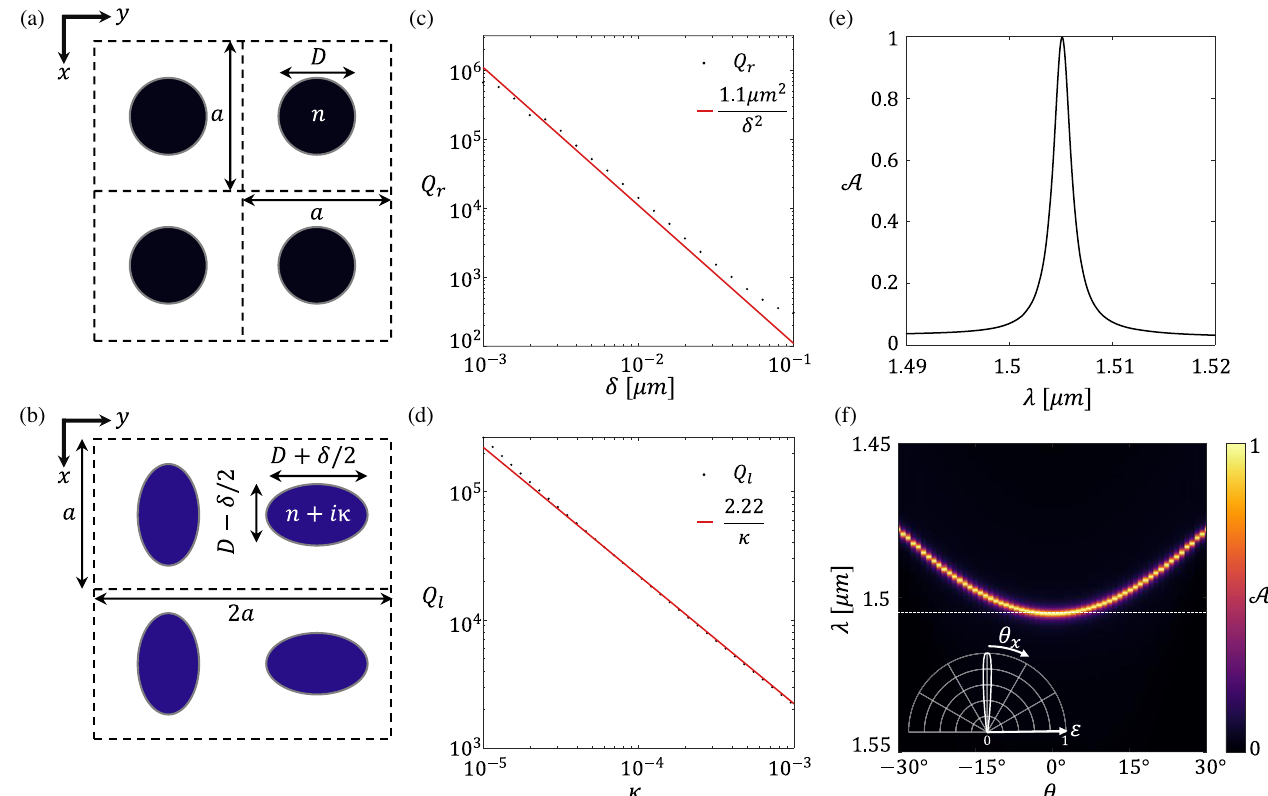
FIG. 3. Perturbative framework for thermally emissive QBICs. (a) An unperturbed high-symmetry lattice of a lossless material with index n is perturbed (b) both geometrically (with asymmetry parameter δ ) and in index (adding a small extinction coefficient κ ). ∝ 1 = δ 2 , and (d) the nonradiative Q factor (for fixed δ ) varies as Q ∝ 1 = κ . Dots in (c,d) (c) The radiative Q factor (for fixed k ) varies as Q r l are calculated by full-wave simulations, while the red lines show linear fits to these data. (e) Absorption spectrum of the QBIC near the resonant frequency for normal incidence and x -polarized light. (f) Absorption spectra for a range of incidence angles, showing perfect absorption following a parabolic angular dispersion. The band-edge mode (dashed white line) emits to a narrow range of angles near the normal (inset). Note: The three-dimensional structure used to calculate (c) – (f) is shown in Figs. 6(a) – 6(c) with the values θ ¼ α ¼ 0